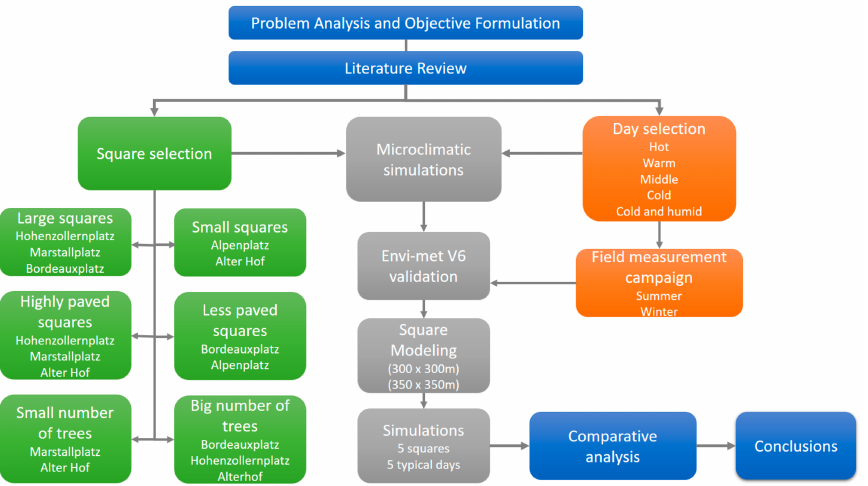
Figure 2. Flowchart of the methodological